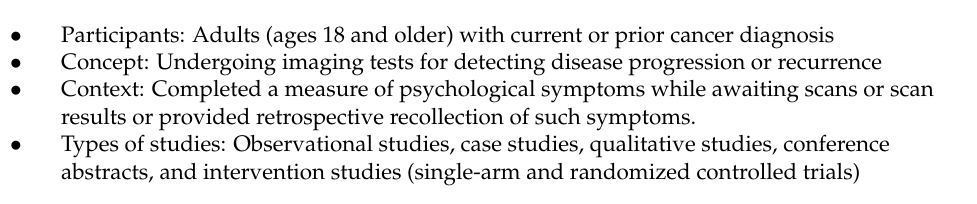
Table 1. Eligibility criteria for full text screening. Inclusion